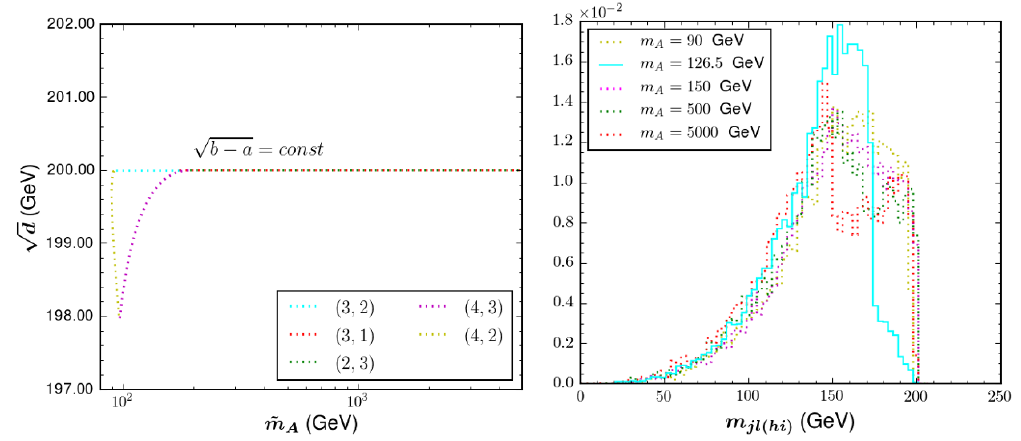
Figure 19 . The analogue of (cid:12)gure 19, but for the (cid:13)at direction de(cid:12)ned in (cid:12)gure 15 (left panel) and for the (cid:12)ve study points from table 2 (right panel).